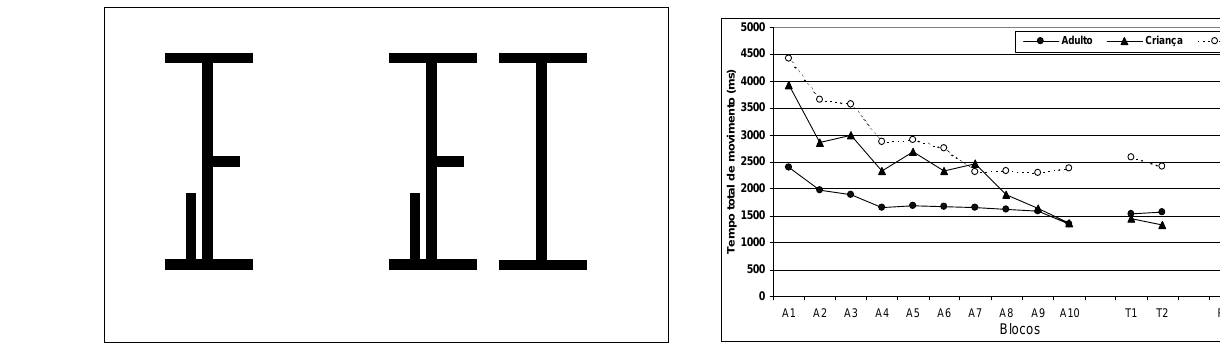
Figura 1 . Padrão Gráfico praticado na fase de aquisição (a) e nos testes de transferência e retenção (b).